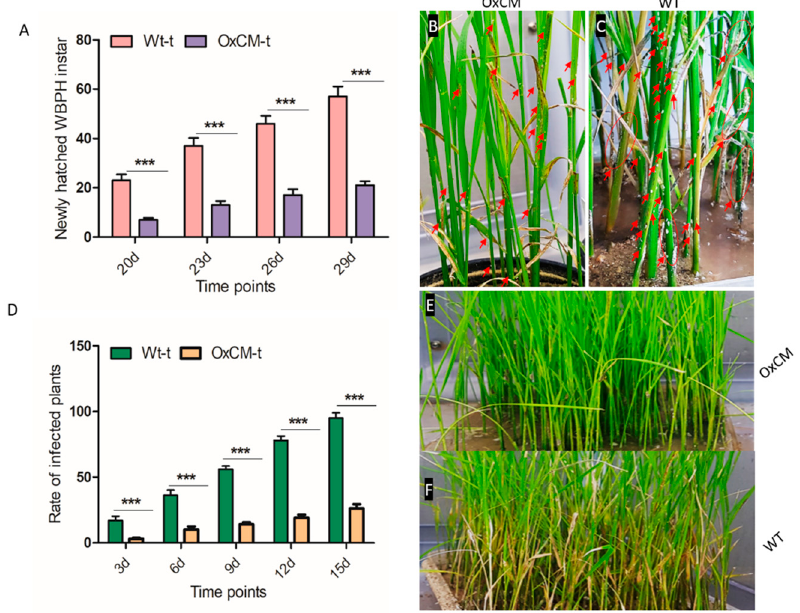
Figure 2. ( A ) Newly hatched instars of white-backed planthopper (WBPH) in wild-type plants infected with WBPH (Wt-t) and chorismate mutase transgenic over-expressor plants infected with WBPH (OxCM-t) after 20, 23, 26, and 29 days of infestation. ( B , C ) Population of newly hatched instar on OxCM and Wt plants, denoted by arrows. ( D ) WBPH infected plants of OxCM and Wt after 3, 6, 9, 12, and 15 days of infestation. ( E , F ) Pictorial representation of WBPH infestation of OxCM and Wt respectively. Graph bars indicate the mean ± standard deviation ( n = 3), and asterisks indicate significant differences (*** p < 0.001) analyzed using two-way analysis of variance and Bonferroni post hoc test. Data presented in graphical form are the means for three independent experiments.